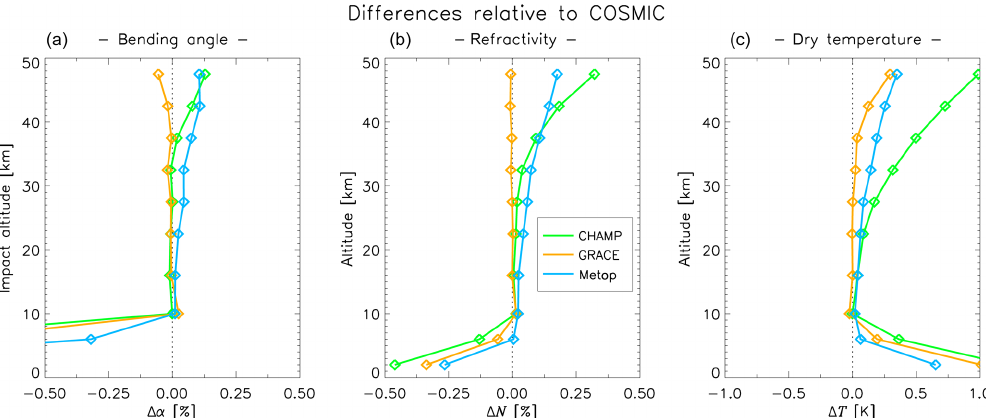
Figure 11. Summary of global CHAMP, GRACE, and Metop differences relative to COSMIC, quantified by the time averages of the mission differences computed over the respective overlap period. The RO data have been binned, averaged, sampling-error corrected, and converted to anomalies according to the methods described in Sect.